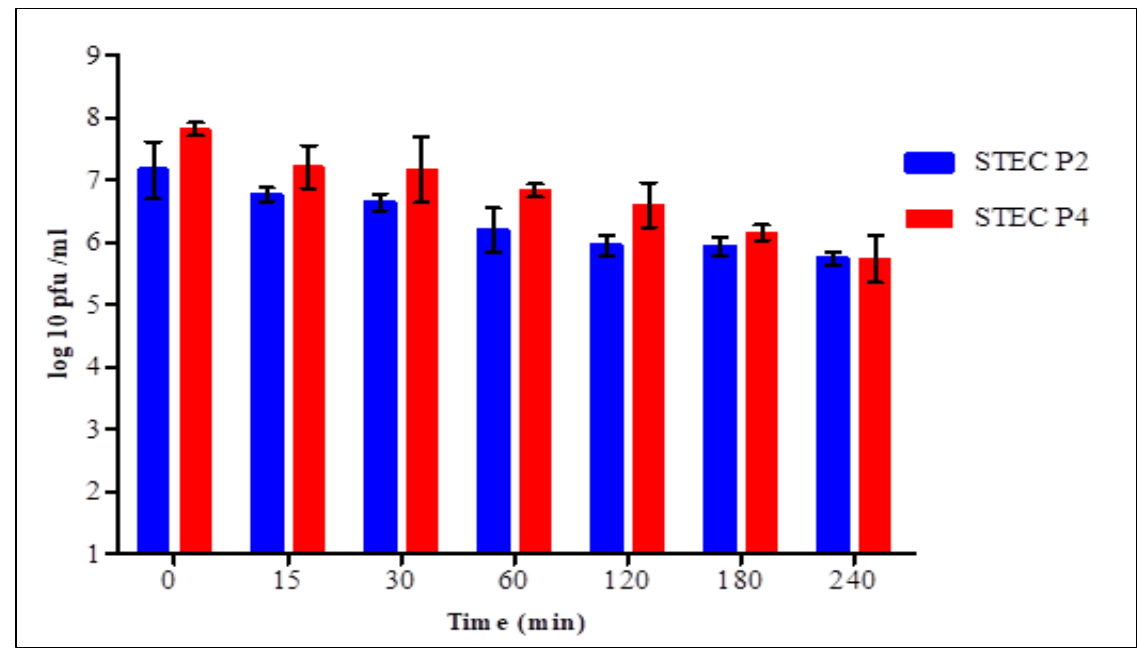
Figure 7. Effect of simulated gastric fluid on the counts of STEC P2 and STEC P4. LSD value at 0.05:0.286.